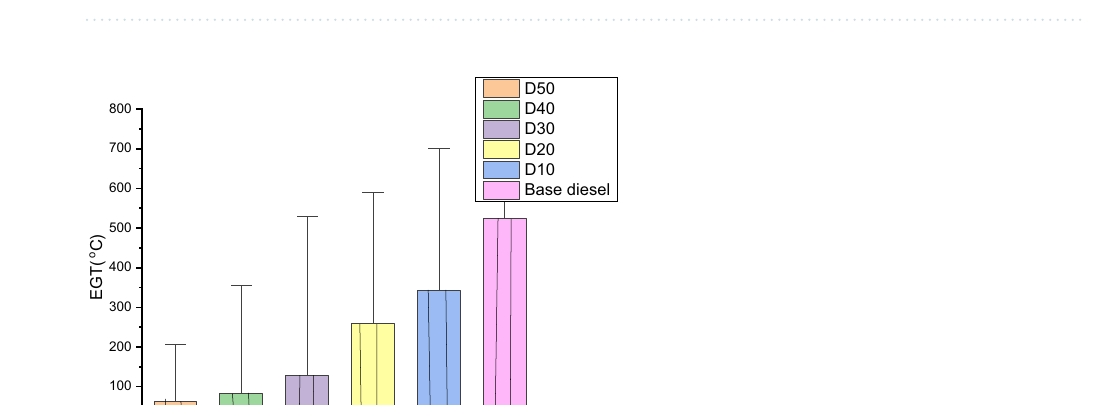
Figure 5. BSFC vs. brake Power.